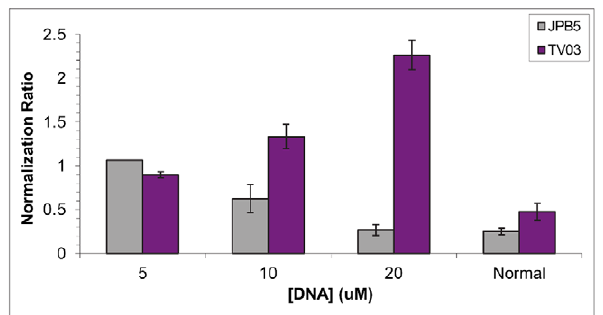
Figure 5. Clotting studies with JPB5 and TV03 control.